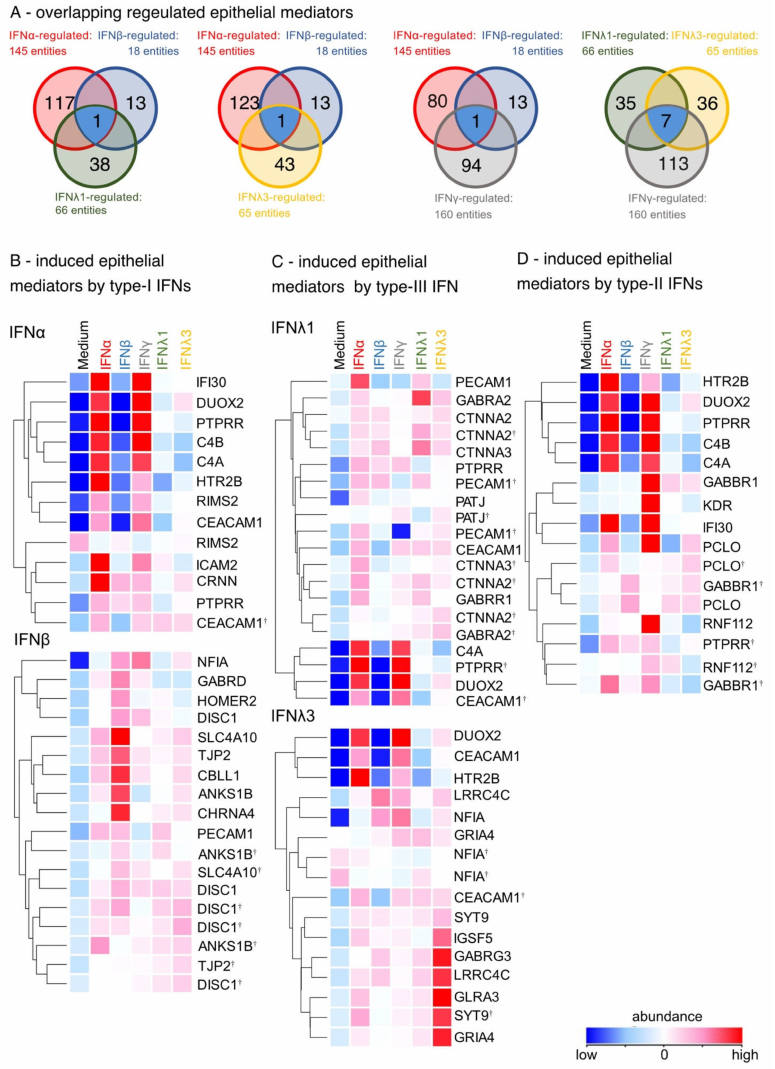
Figure 5. Type-I, -III and -II IFNs enhance the differentially induction of epithelial mediators. ( A ) Venn blot of overlapping regulated epithelial mediators by type-I, -II and -III